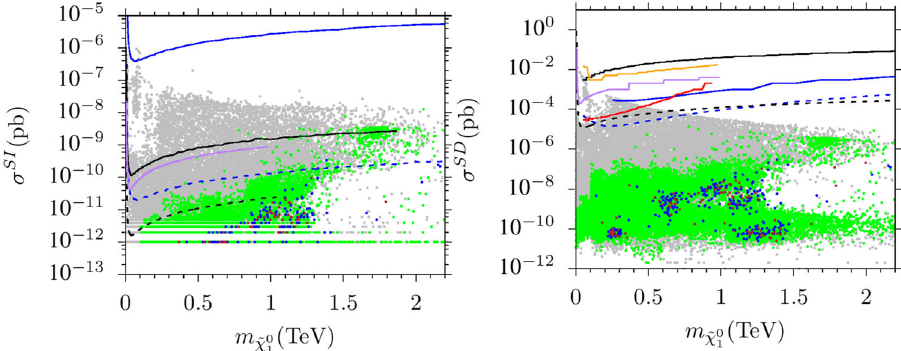
Fig. 11 The Spin-independent and Spin-dependent scattering cross- sections of the dark matter. All points are compatible with the REWSB and LSP neutralino conditions. Green points are allowed by the mass bounds and constraints from rare B − meson decays. Blue and brown points are subsets of green, and they satisfy, respectively, the WMAP and Planck bounds on the relic abundance of LSP neutralino within 5 σ . In the σ SI − m ˜ χ 0 plane, the blue solid (dashed) curve represents the cur- 1 rent (projected) results of the CDMS experiment [206], while the black solid (dashed) curve is the current (projected) exclusion from the LUX-